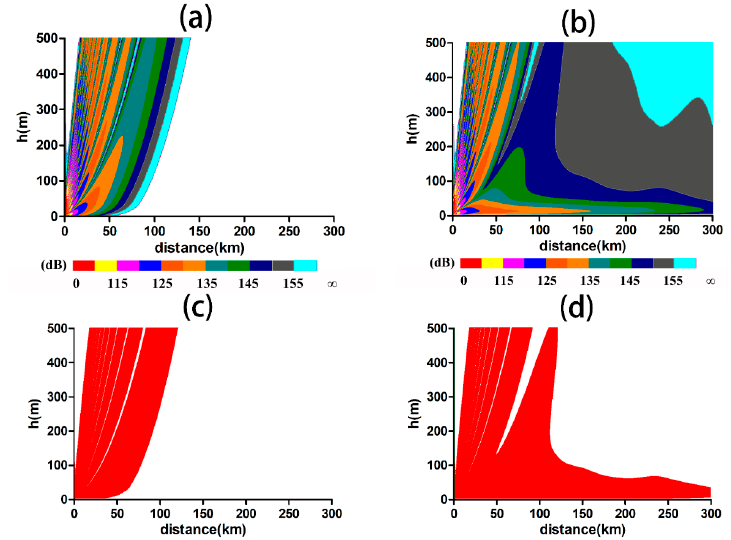
Figure 12. Typical traits of electromagnetic fields based on the PE model at different BSISO phases: left column corresponds to an active BSISO event, and the right corresponds to negative. ( a , b ) loss of electromagnetic propagation under evaporation duct conditions; ( c , d ) blind zone in the electromagnetic